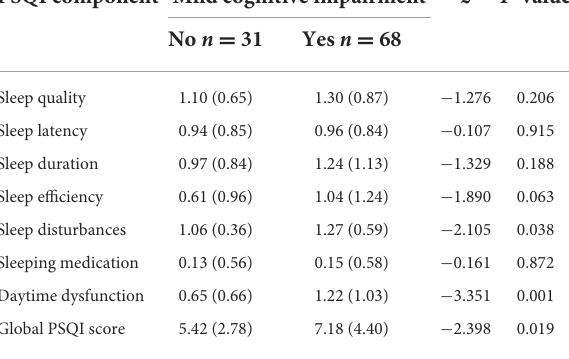
TABLE 4 Comparison of Pittsburgh sleep quality scale scores between the two groups ( n =